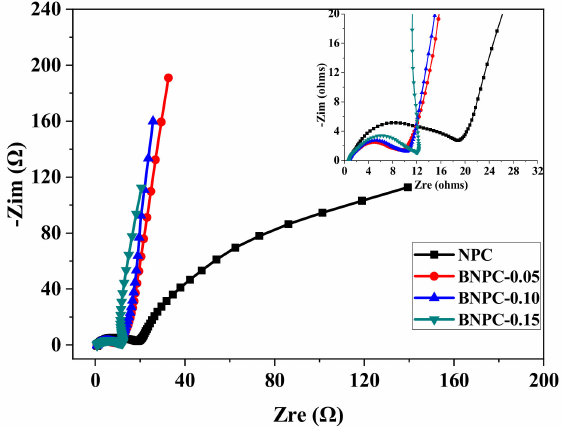
Figure 6. The Nyquist plots of the NPC and BNPC-X electrodes (the inset shows the expanded high-frequency region of the